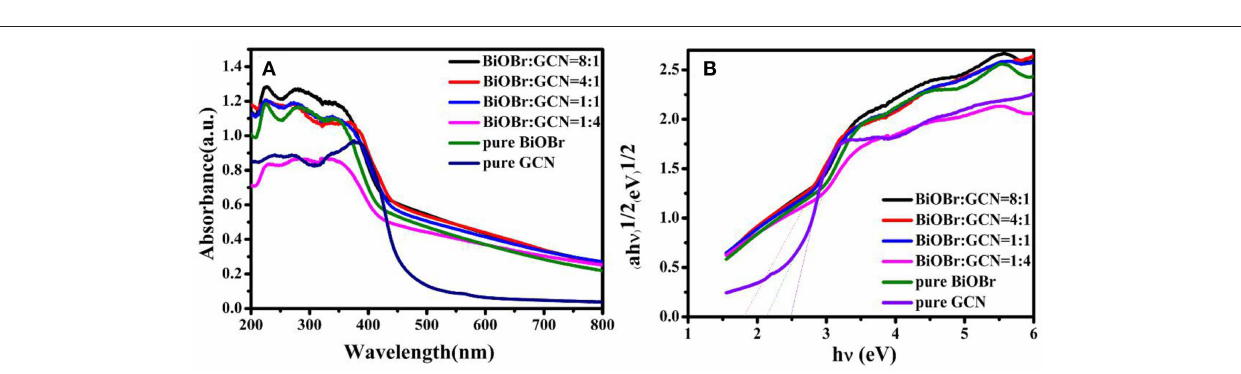
FIGURE 4 | (A) UV-vis diffuse reflectance spectra and (B) the band gap energies ( E g ) of pure BiOBr and g-C 3 N 4 , BiOBr-g-C 3 N 4 composites.